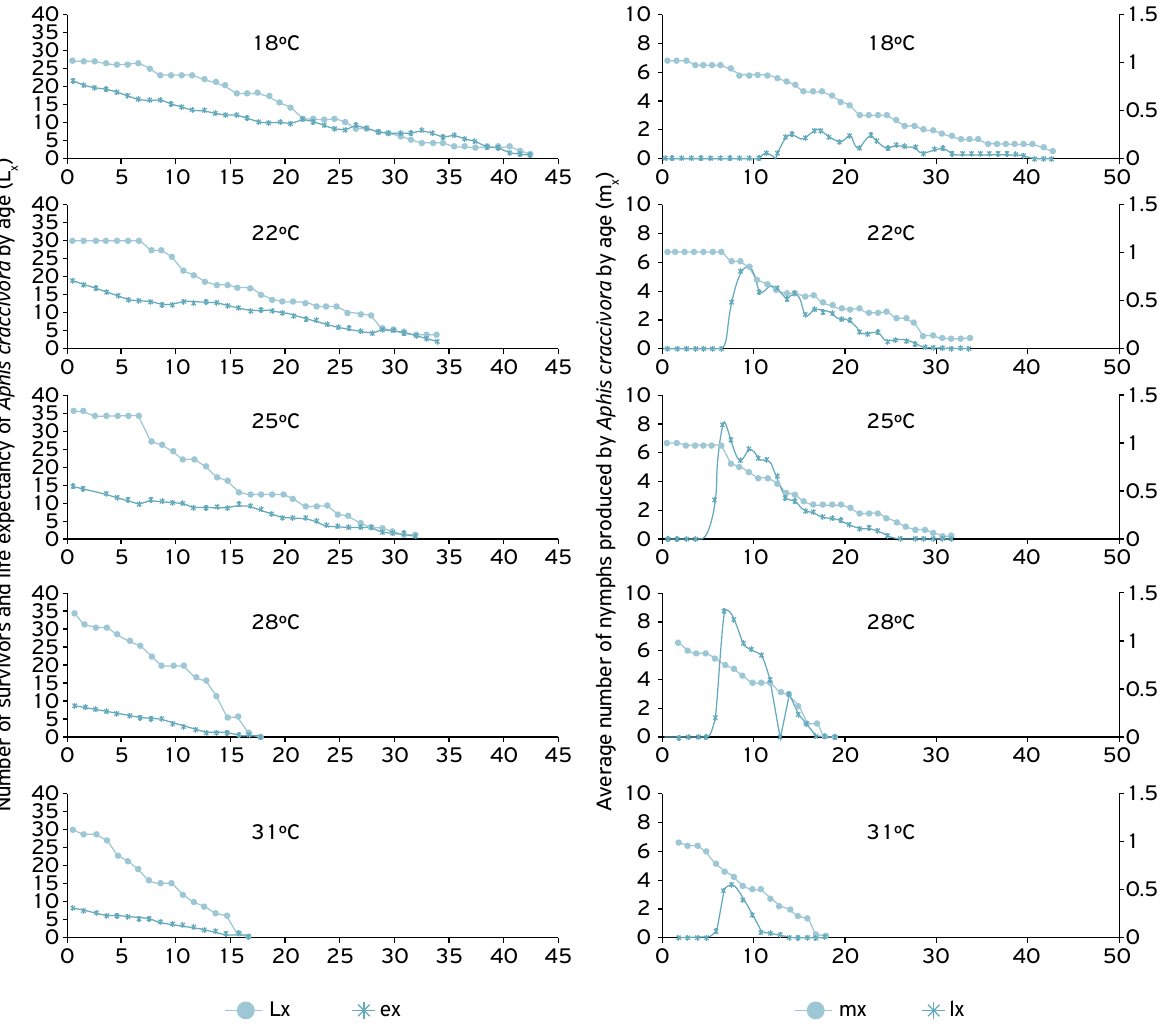
), life expectancy (e ) and specific fertility (m x x